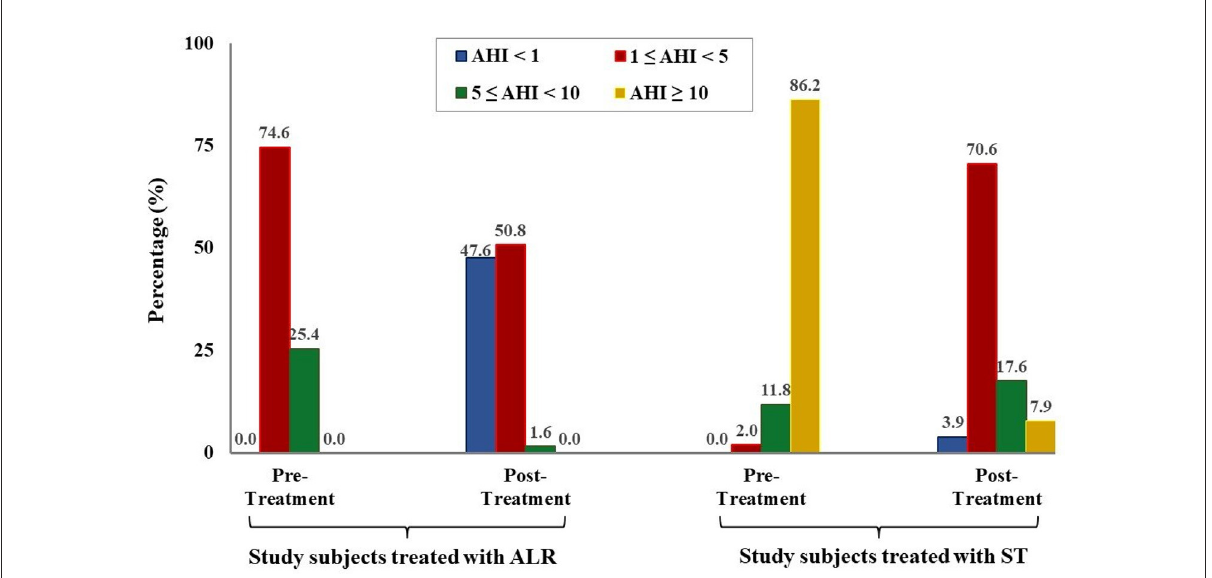
FIGURE3 Modification of OSA severity after treatment in study subjects. AHI, apnea-hypopnea index; ALR, anti-leukotriene receptor; SG, surgical therapy.